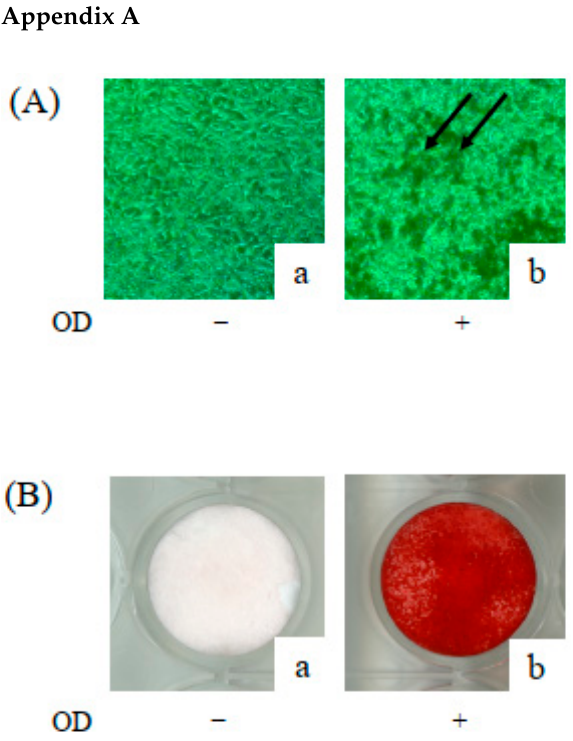
Figure A1. KUSA-A1 cells provide a suitable model of osteogenesis. Cells were cultured for 7 days without ( − ) or with (+) L-ascorbic acid phosphate, dexamethasone, and beta-glycerophosphate. ( A ) Mineralized nodules were observed ( b , arrows). ( B ) Calcium deposition was visualized by alizarin red S staining ( b ). Mineral deposition by KUSA-A1 cells demonstrated that they have the capacity to differentiate into osteoblasts. OD: osteo-differentiation.